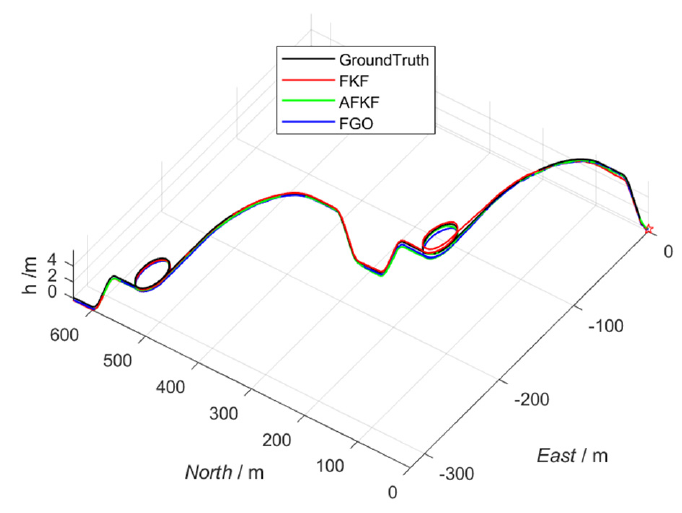
Figure 7. Comparison of different algorithm trajectories.